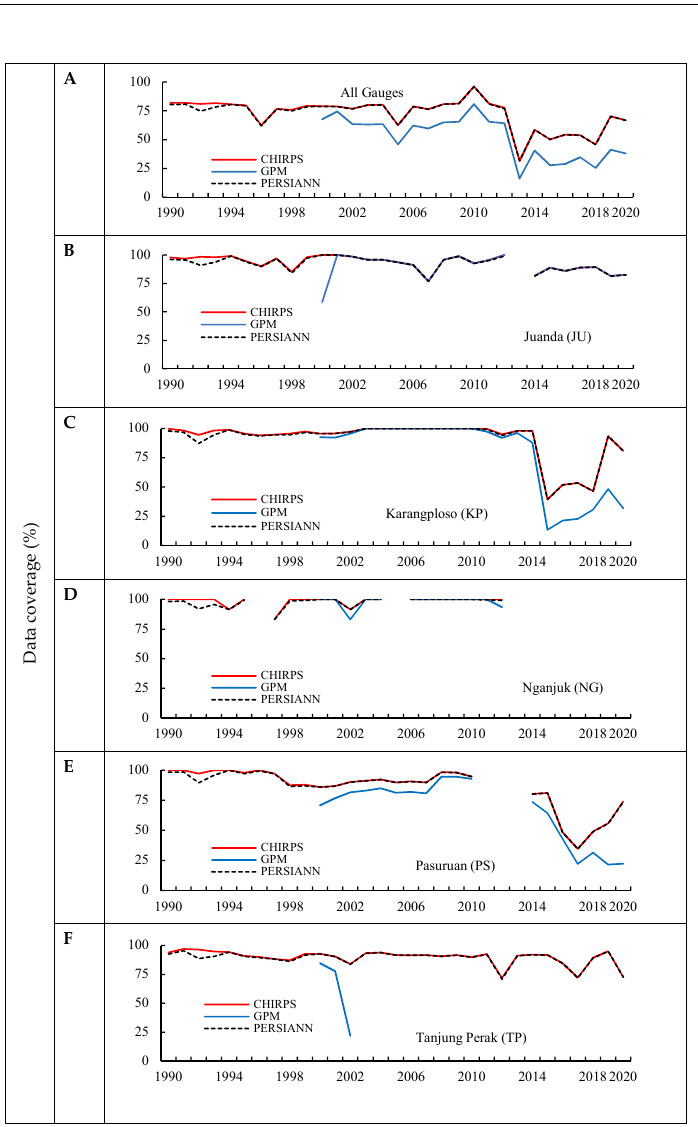
Figure 2. Rainfall data coverage (%) for each rain gauge locations: combined all statons ( A ), Juanda ( B ), Karangploso ( C ), NGanjuk ( D ), Pasuruan ( E ), and Tanjung Perak ( F ).